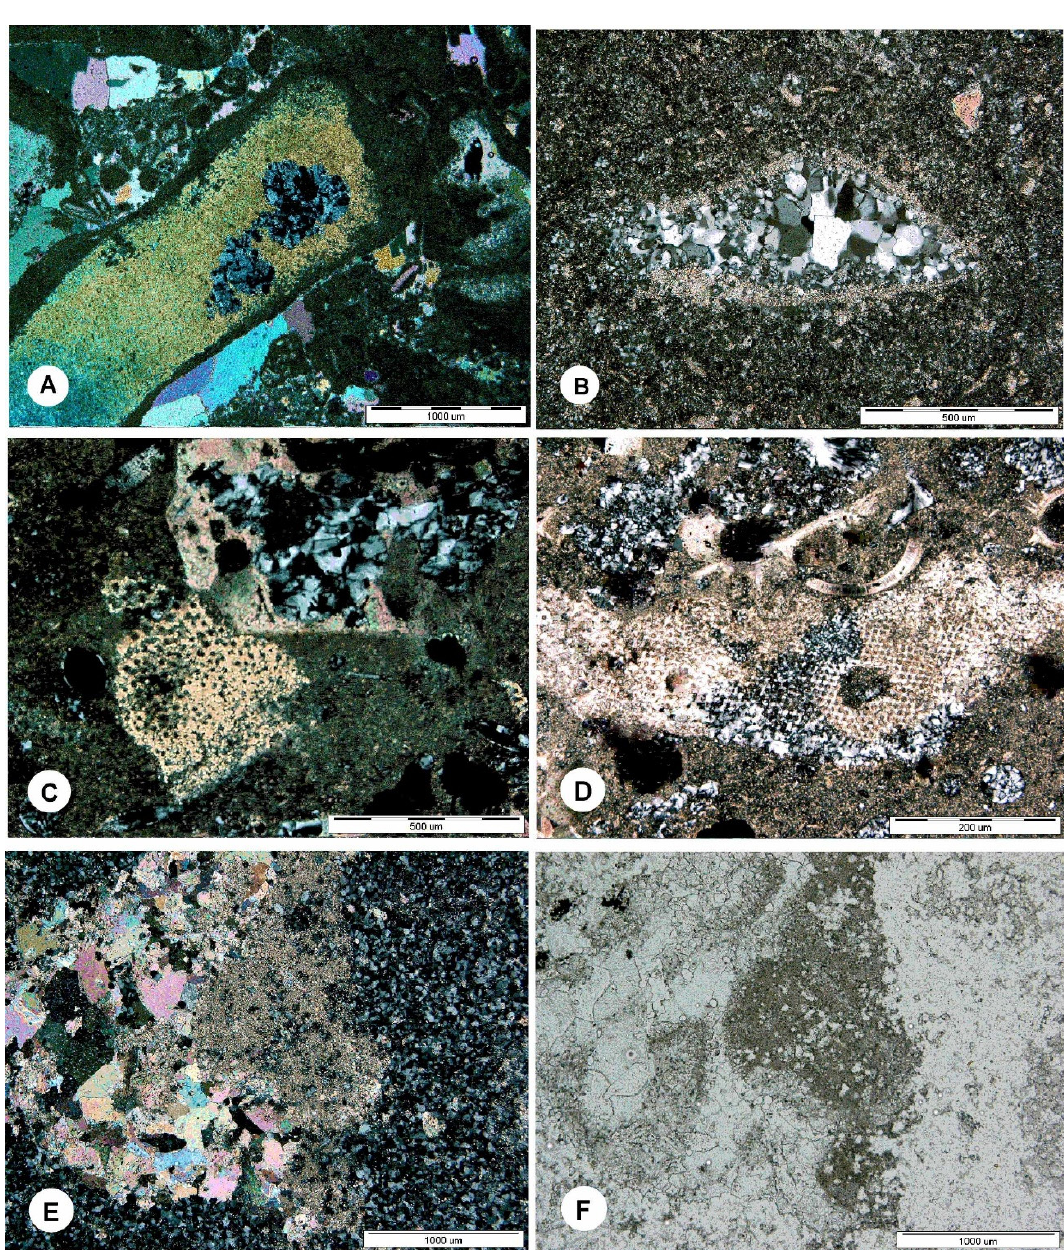
Figure 6. Examples of silification. Polarizing microscope: ( A ) A carbonate bioclast with traces of silification in organogenic limestone, 2P; ( B ) Relics of carbonate minerals in limestone encompassed by the silification process, 2P; ( C ) Replacing carbonates with microcrystalline chalcedony; ( D ) Silica filling of the intercellular space of the sponge skeleton; ( E ) Calcite relics, 2P; ( F ) Calcite relics,